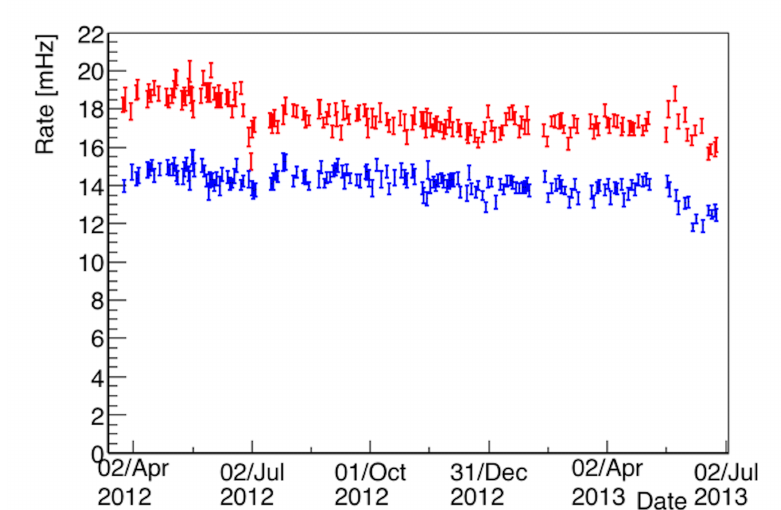
Figure 1. Rates of the cosmic ray events collected on the west (blue) and on the east (red) cryostat, in the period analyzed for the atmospheric neutrino search. The difference between the two modules is related to the different number of PMTs installed: in the east module 54, PMTs were present, while in the west module, only 20 PMT were